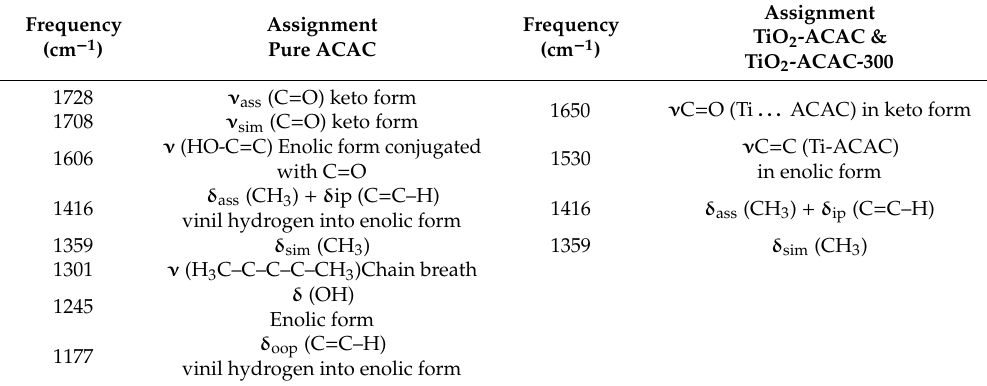
Figure 3. ( a ) Fourier-transform infrared (FTIR) spectra of pure acetylacetone and ( b ) TiO 2 -ACAC, TiO 2 -ACAC-300 and TiO 2 -ACAC-400. Table 1. Assignments for vibrational band frequencies in the region 1700–1000 cm − 1 for the keto-enolic ACAC and for TiO 2 -ACAC and TiO 2 -ACAC-300.